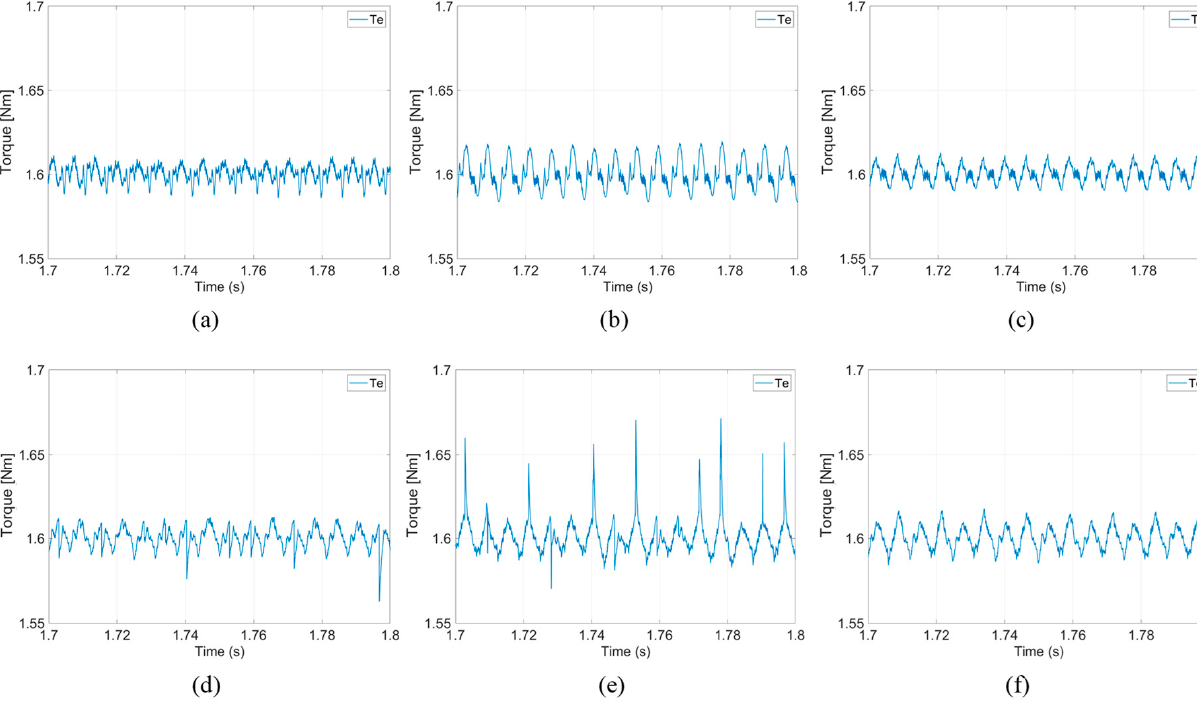
Figure 12. Simulation results of motor torque in steady state at 400 rpm and 1.6 Nm of load torque: ( a ) SPWM; ( b ) THPWM; ( c ) SVPWM; ( d ) 60° DPWM; ( e ) 30° DPWM; ( f ) 120° (off) DPWM.